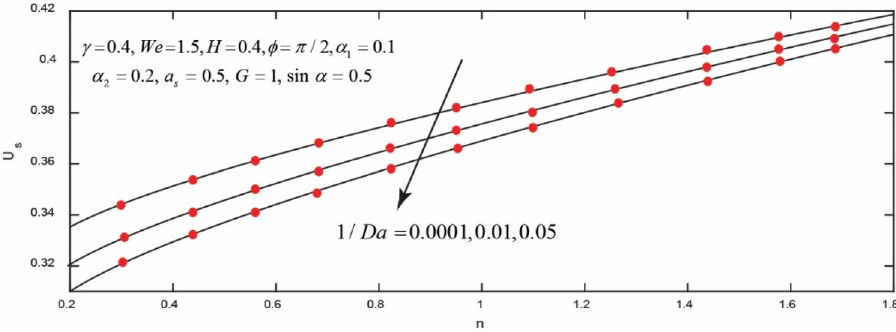
Figure 2. Influence of Darcy number Da on organisms swimming speed.